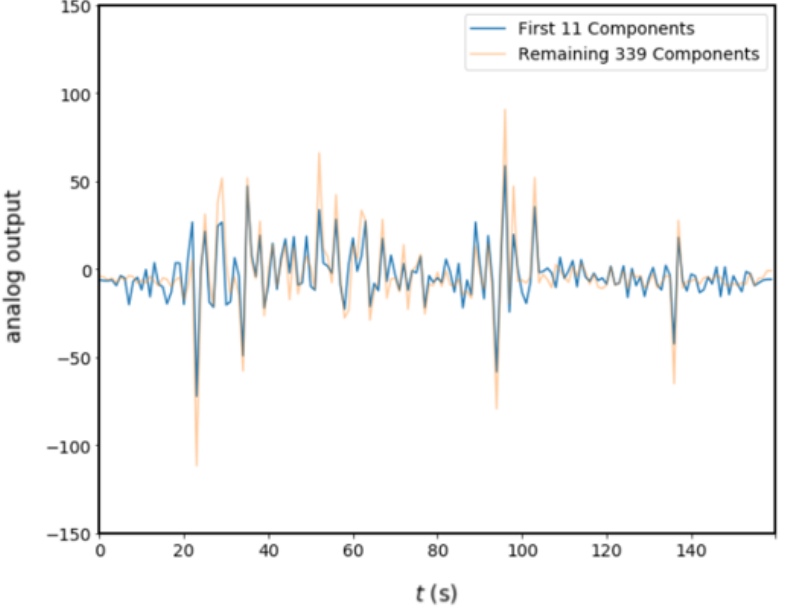
Figure 11. Reconstructed data through Singular Spectrum